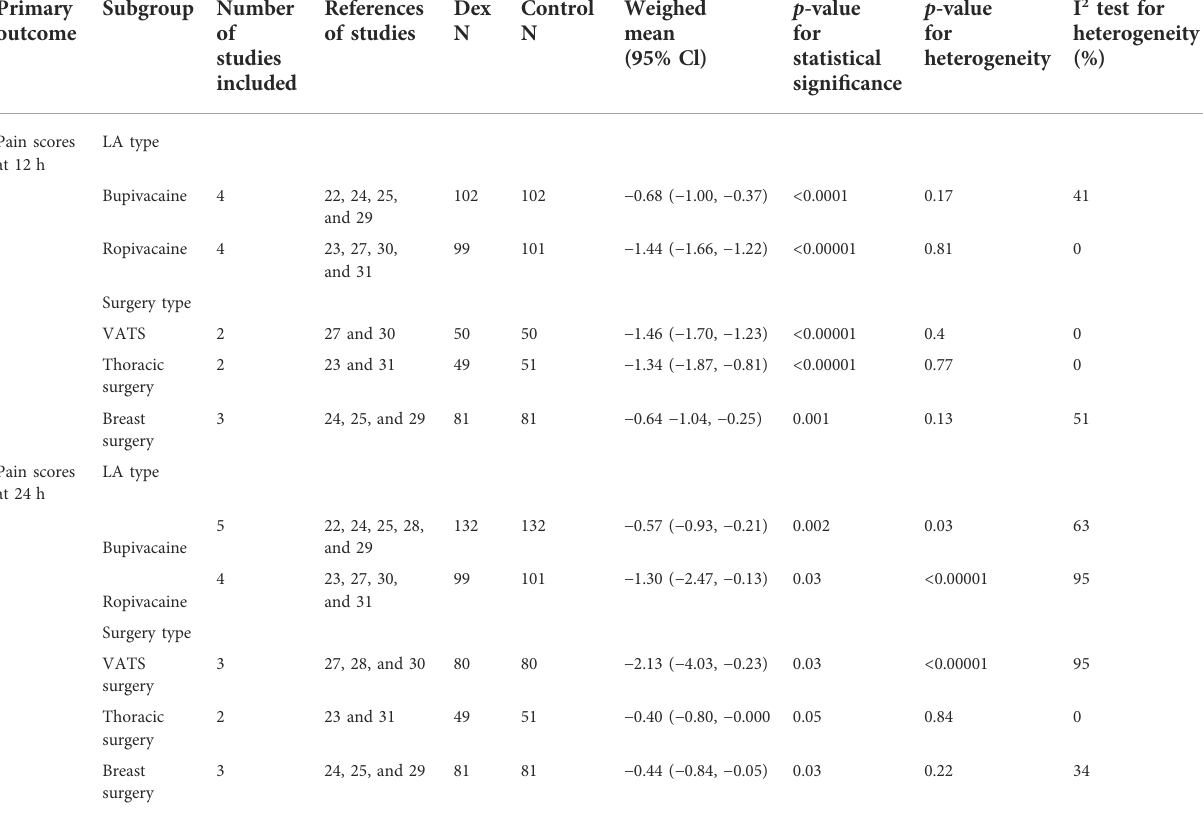
TABLE 2 Summary of subgroup analysis of dexmedetomidine on postoperative pain scores at 12 and 24 h.